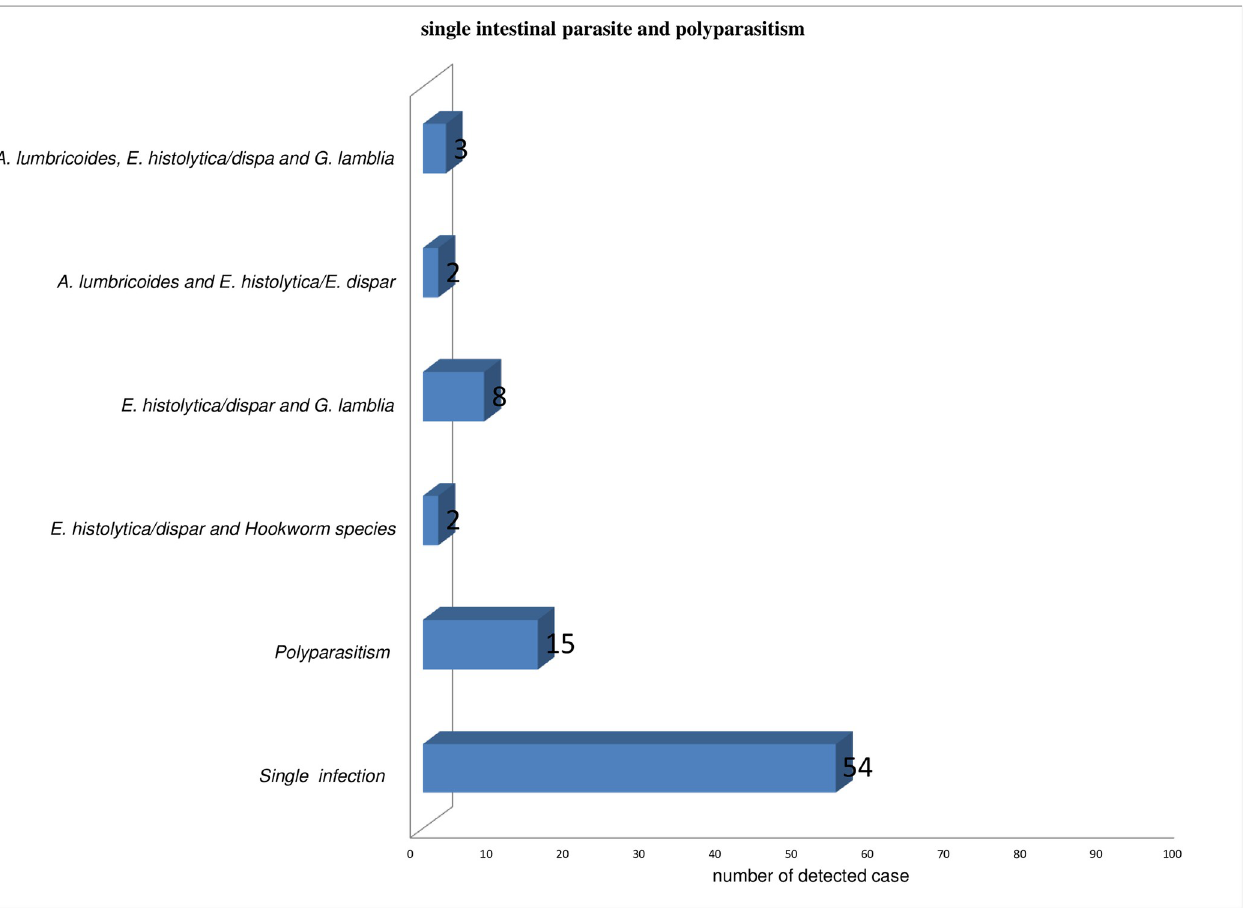
Fig 1. Distribution of single parasitic infection and polyparasitism among patients attending Arba Minch general hospital outpatient department during COVID 19 pandemic (from June-to November 2020). X axis in the bar graph is the type of intestinal parasitic infection and the Y axis is the number of intestinal cases with each type of parasitic infection.